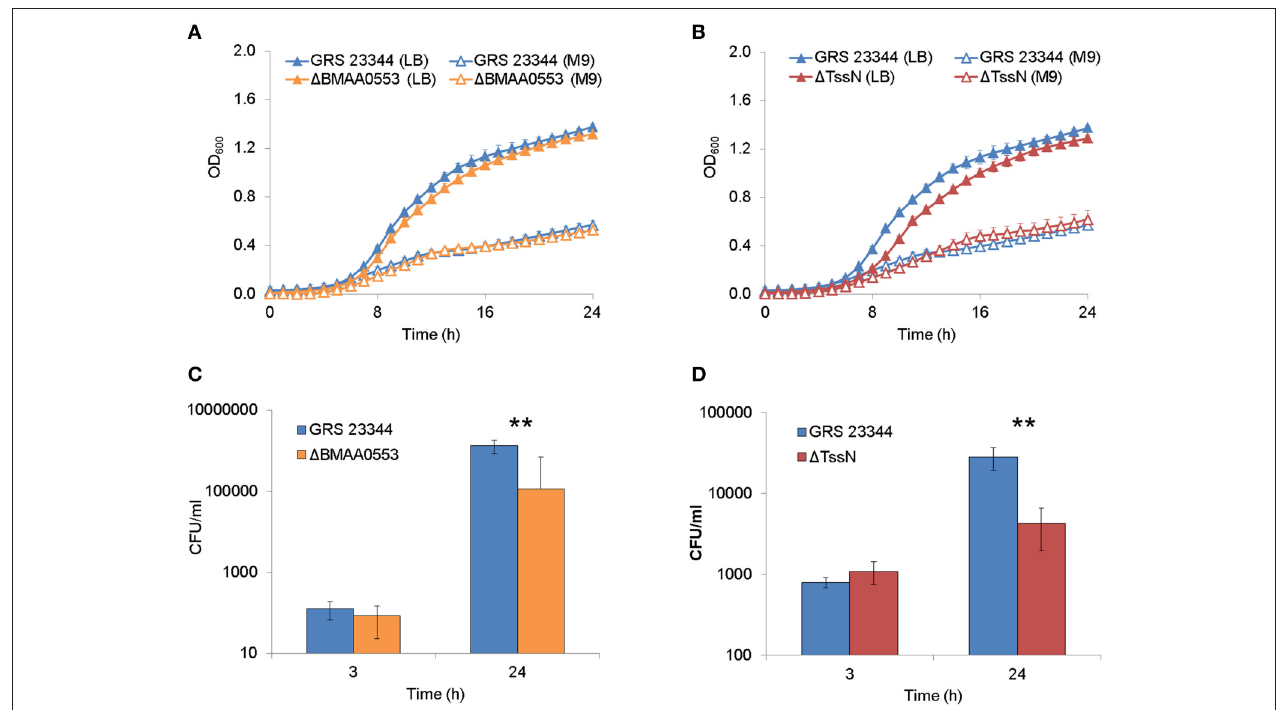
FIGURE 1 | Extracellular and intracellular growth. Bacterial growth, as measured by optical density at 600nm (OD 600 ), in nutrient-rich LB media + 4% glycerol (LB) and nutrient-limited minimal media (M9) are shown over 24h for deletion strains 1 BMAA0553 (A) and 1 TssN (B) compared with the parental strain GRS 23344. Bacterial growth in RAW 264.7 macrophage-like cells is shown after 3 and 24-h incubation for GRS 23344 and 1 BMAA0553 at an MOI of 4 (C) , and GRS 23344 and 1 TssN at an MOI of 8 (D) . Growth was measured in terms of colony forming unit (CFU) recovery using gentamicin protection assays. Error bars represent standard errors from mean values determined from 2 to 4 replicates/assay. An “ ** ” corresponds to a significant difference at p < 0.001